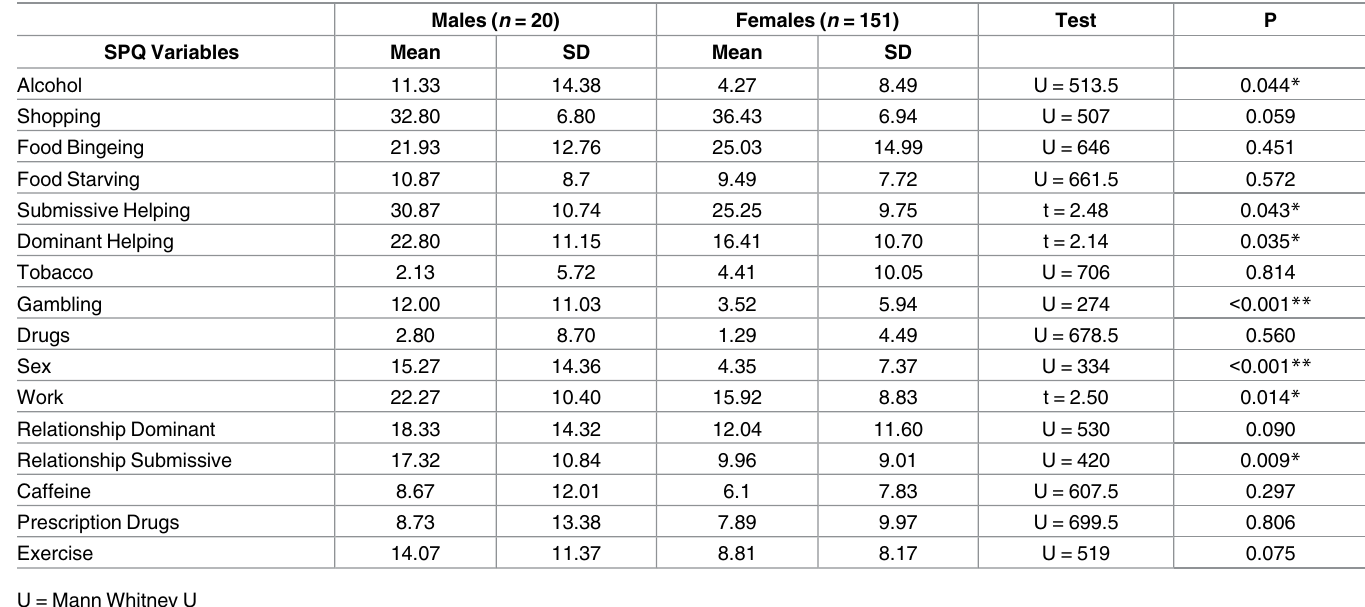
Table 3. Differencesbetween men and women in addictive behaviors in a sample of compulsive buyers.